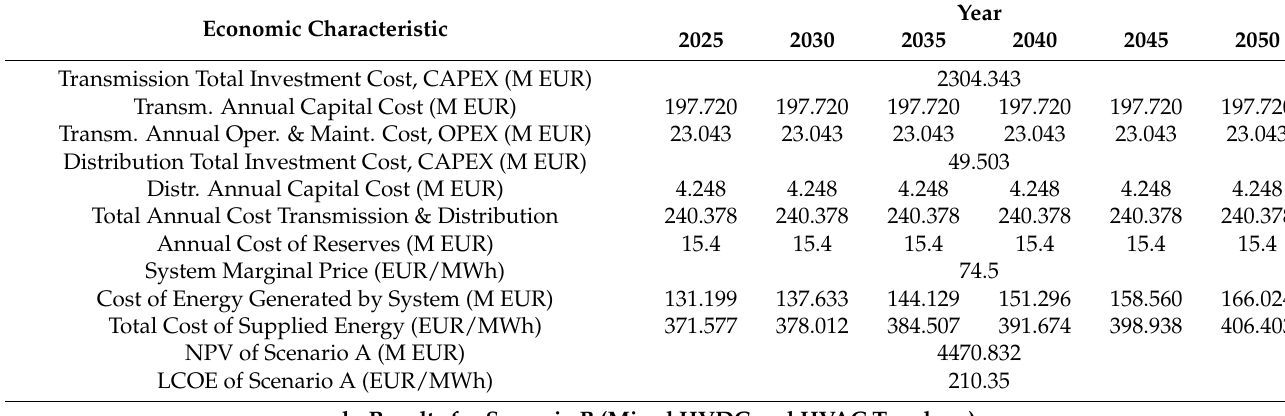
Table 5. Economic